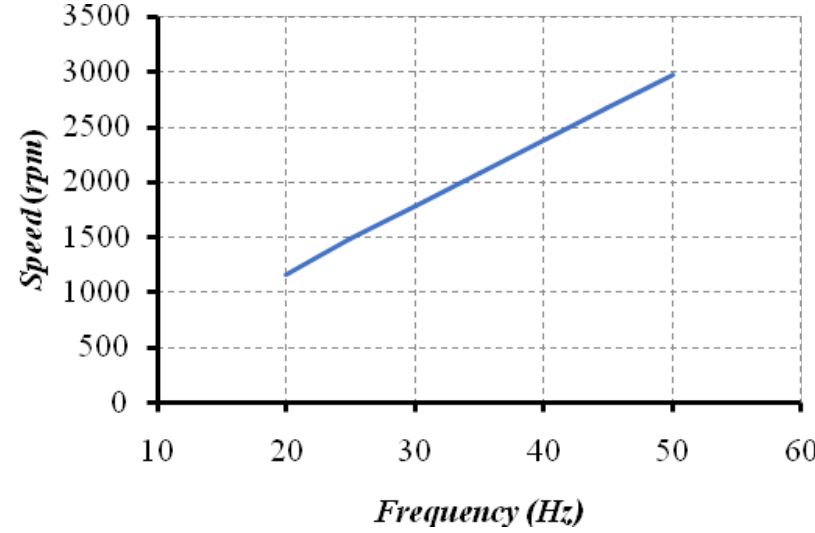
Figure 15. Measured rotor speed against frequency relationship.